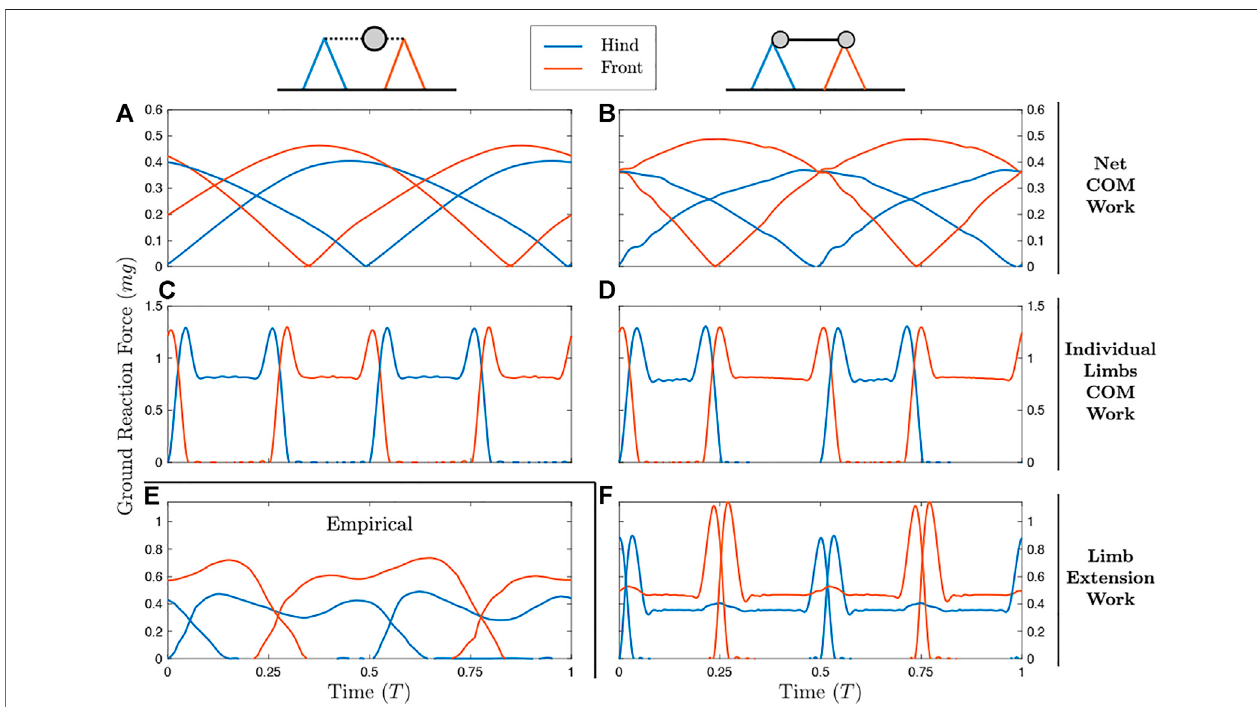
FIGURE2| Groundreactionforces(GRFs)forthepointmassmodel(leftcolumn)anddistributedmassmodel(rightcolumn)withdifferentmeasuresofwork(rows). Diagramsshowapproximateplacementofpointmass(left)andradiiofgyration(right). (A,B) OptimizingonNetCOMWorkresultsindutyfactorsclosetooneandsingle- peak GRFs. (C,D) The Individual Limbs COM Work objective results in alternatingperiodsofsingle-stance vaulting, withdouble-hump GRFs. (E) Empirically, horses ina medium walk display double-hump GRFs with alternating periods of double and triple support. These features are reproduced only in (F) the distributed mass model with Limb Extension Work as the objective. For the planar model results, left and right limb contact can be swapped with no change to the model results, and so only hind and forelimbs are